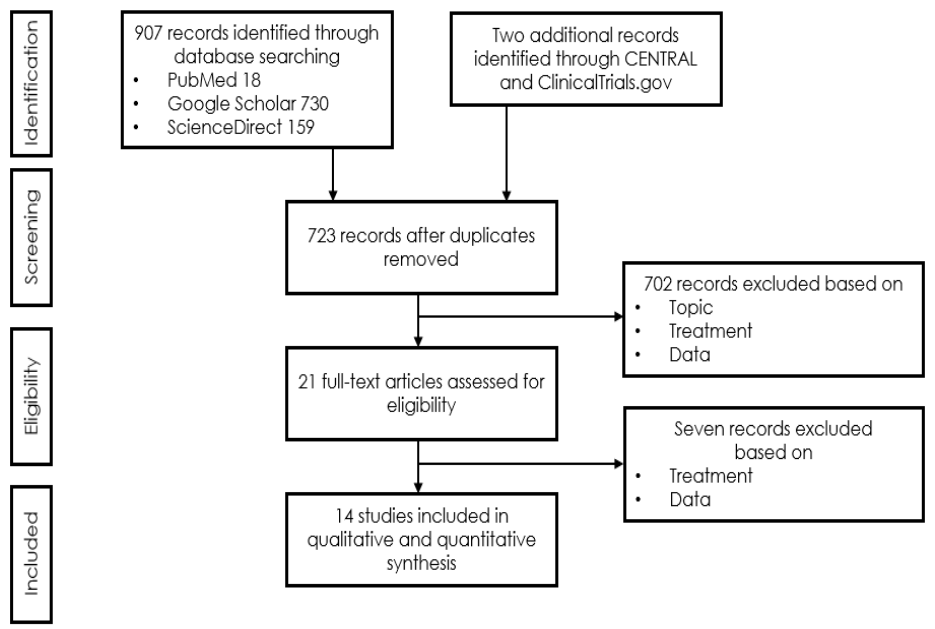
Figure 5. PRISMA (Preferred Reporting Items for Systematic Reviews and Meta-Analyses) search flow.